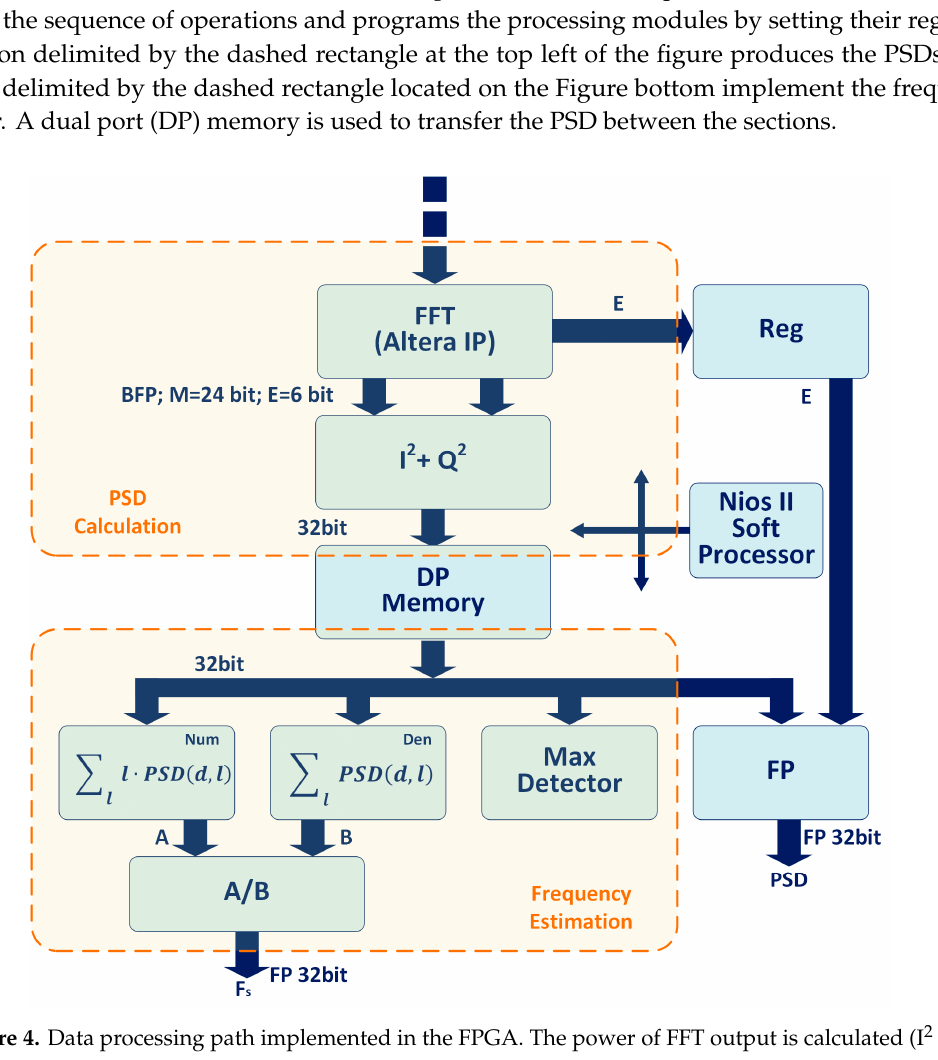
Figure 4. Data processing path implemented in the FPGA. The power of FFT output is calculated (I 2 Q 2 ) and the resulting PSD is saved in a DP memory. Its maximum is detected (Max detector), then the numerator (Num) and denominator (Den) of the centroid formula are calculated. The results are divided, converted in floating point (A / B), and downloaded to host together with the data in memory. A Nios II soft processor supervises the